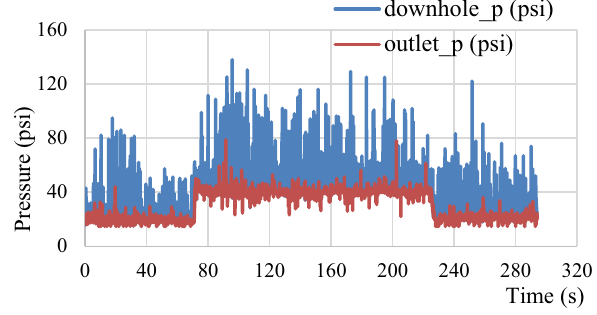
Fig. 12 Effects of gas kick on mass flow rate of the return fluid for